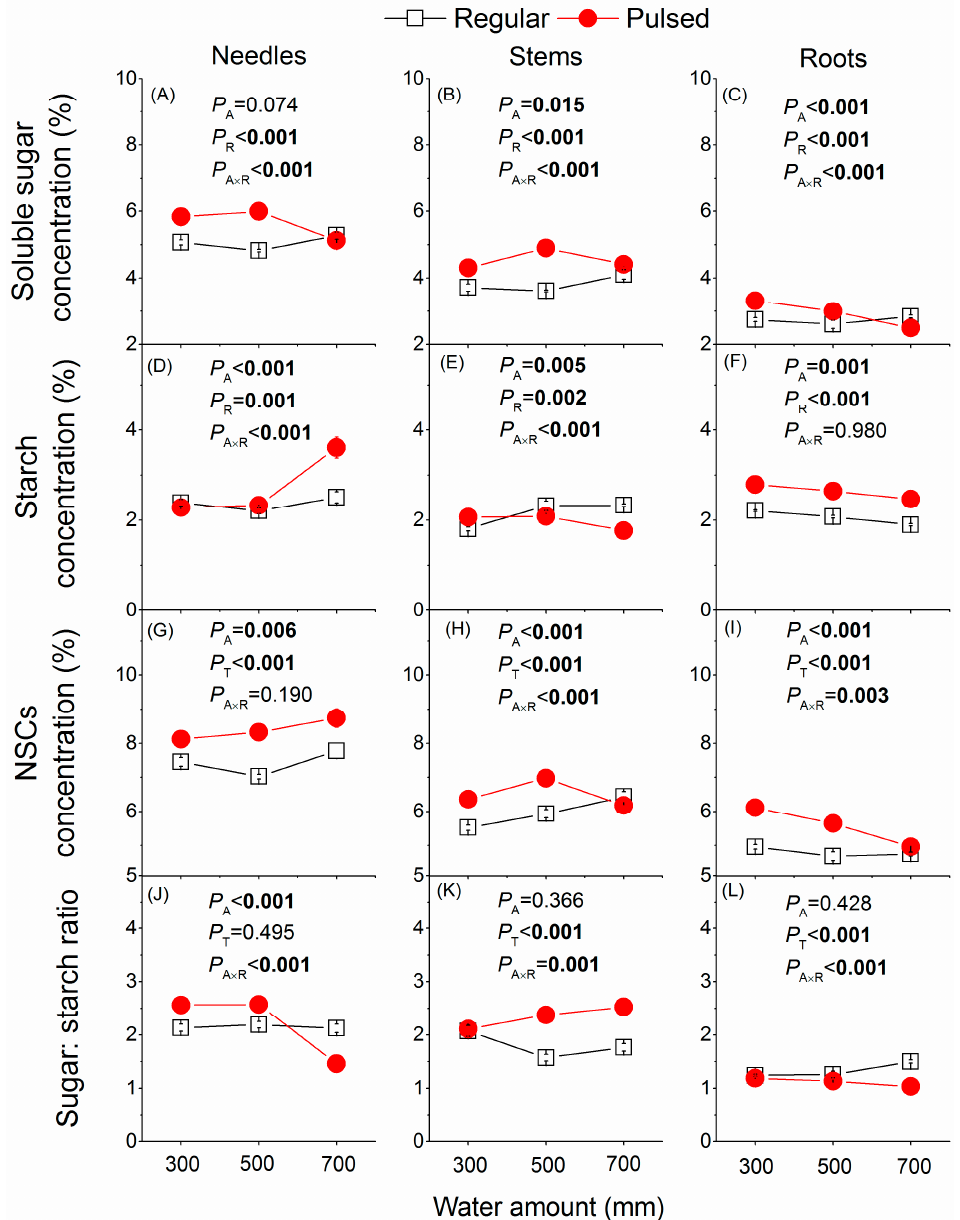
Figure 4. Effects of the watering regime (regular vs. pulsed) and water amount (300, 500, and 700 mm) on concentrations of soluble sugars ( A – C ), starch ( D – F ), NSCs ( G – I ), and soluble sugar to starch ratio ( J – L ) in different tissues of P. massoniana saplings. p values of two-way ANOVAS are given. A and R represent water amount and watering regime, respectively. Plotted are means ± SE.